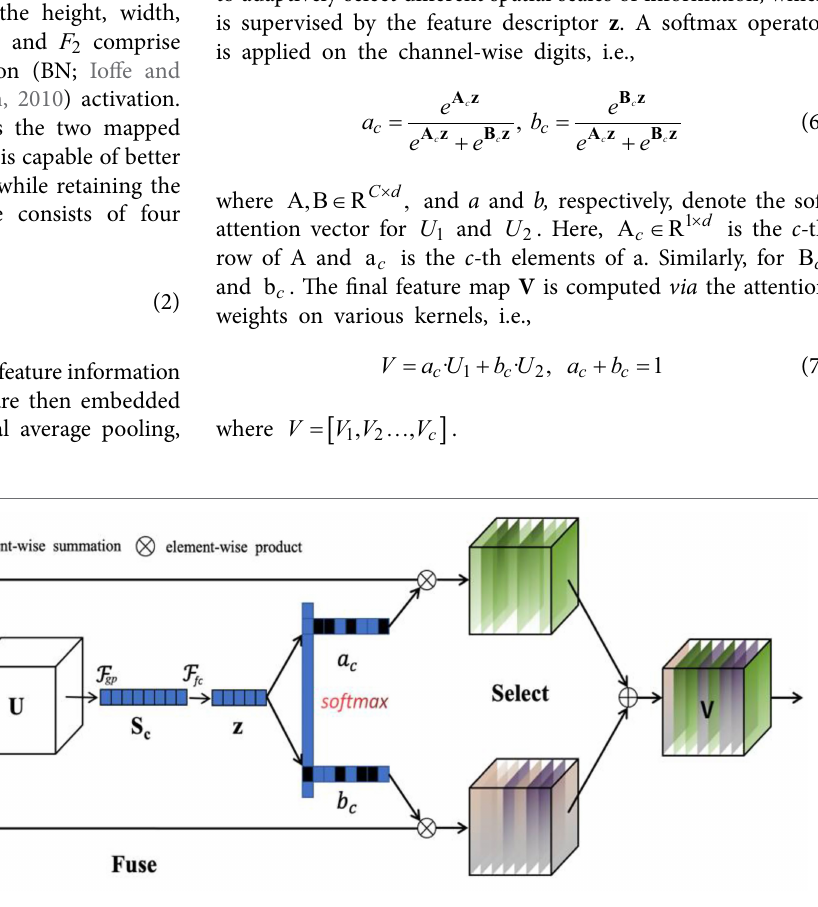
FIGURE 3 | Selective kernel attention enhancement